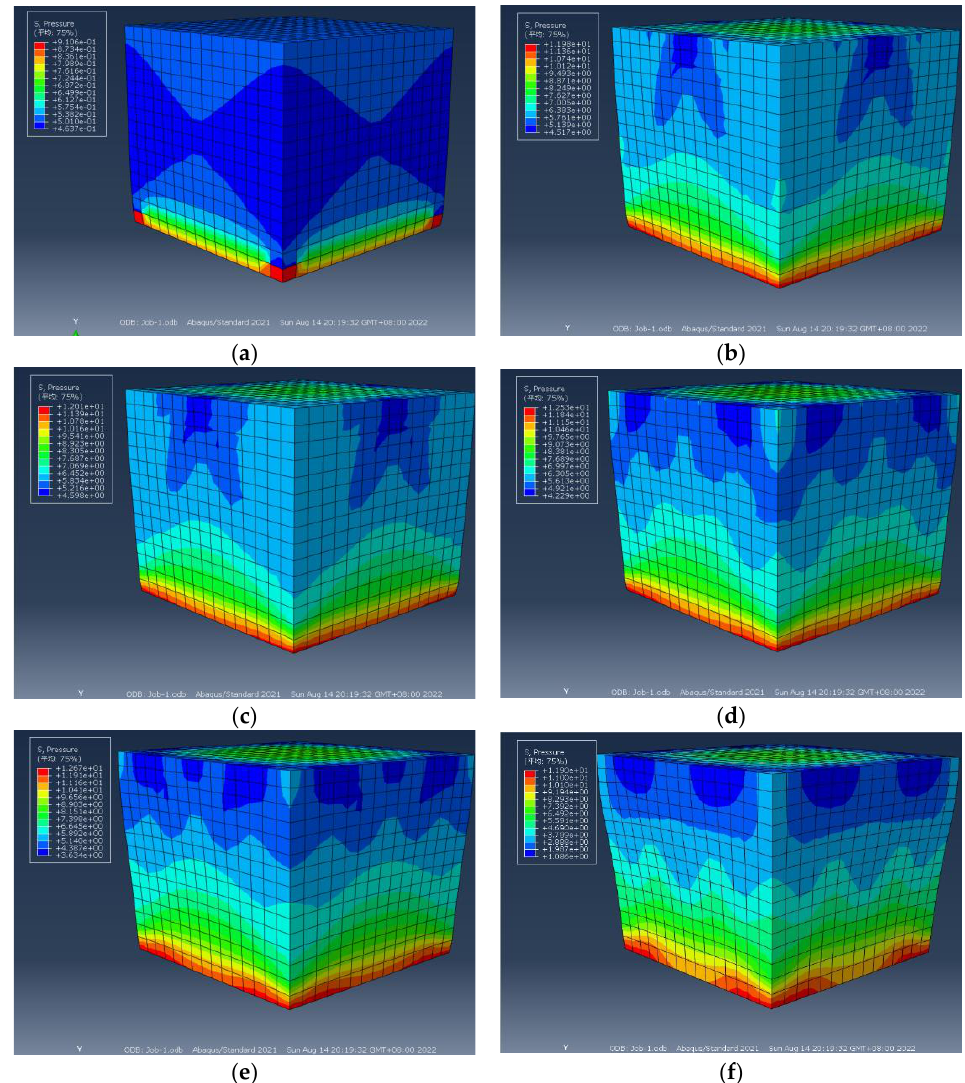
Figure 3. Compression of concrete test blocks at different time steps. ( a ) step 1. ( b ) step 10. ( c ) step 20. ( d ) step 30. ( e ) step 40. ( f ) step 50.